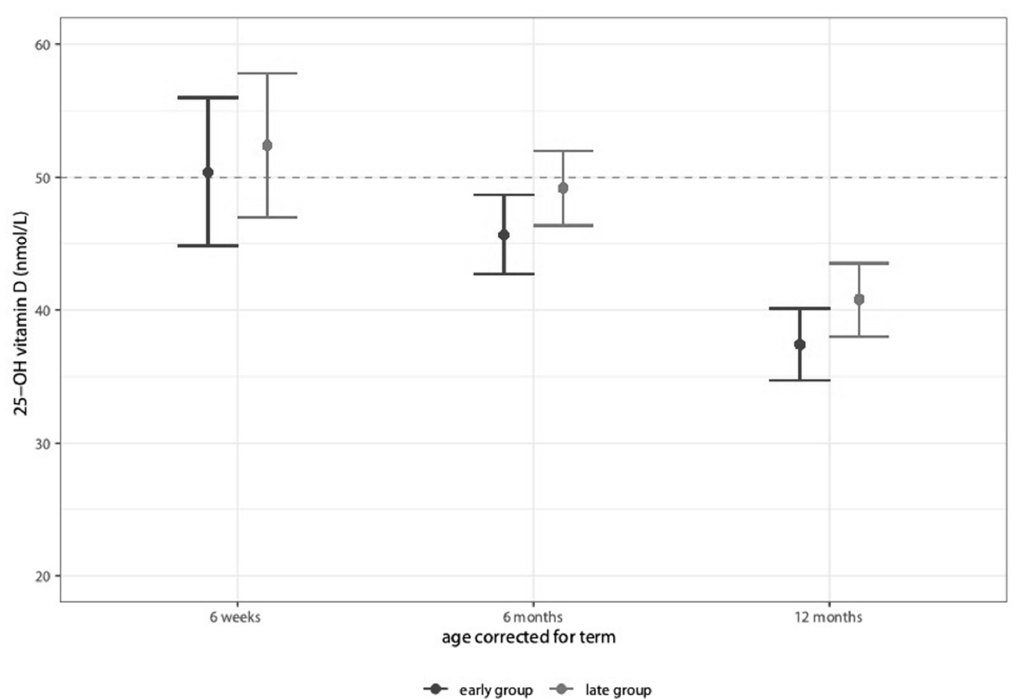
Figure 1. 25-OH-vitamin D levels at 6 weeks, 6 months, and 12 months corrected age.